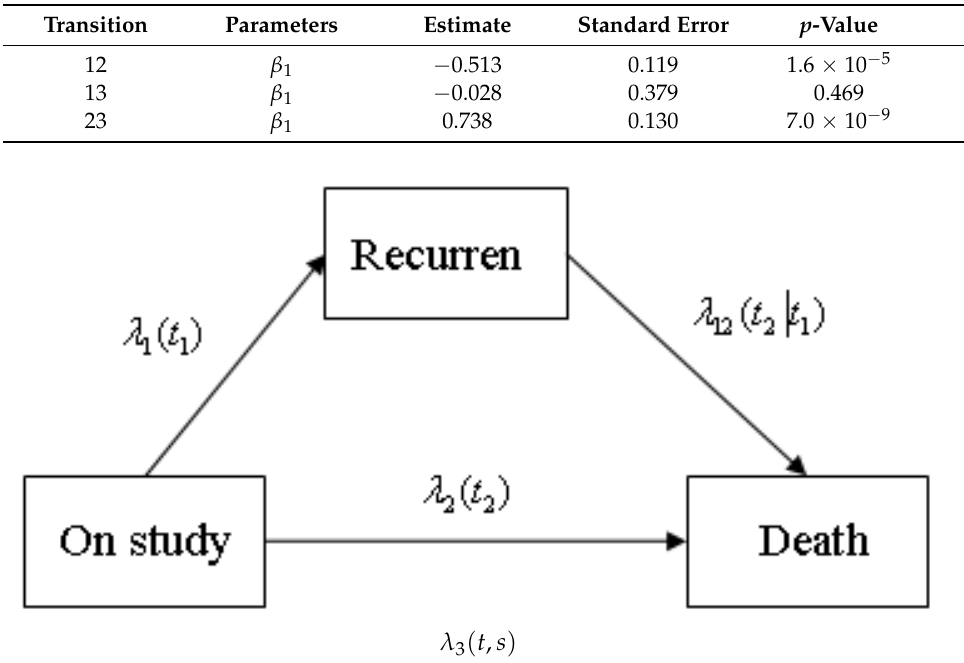
Figure 1. Compartment model for semicompeting risks